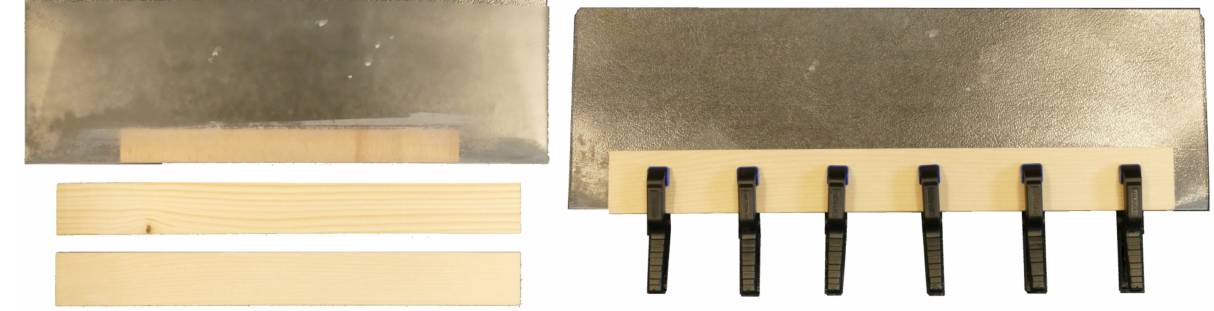
Figure 8. Various steps for clamping the veneer composite by means of boards and clamps in a plastic sleeve.